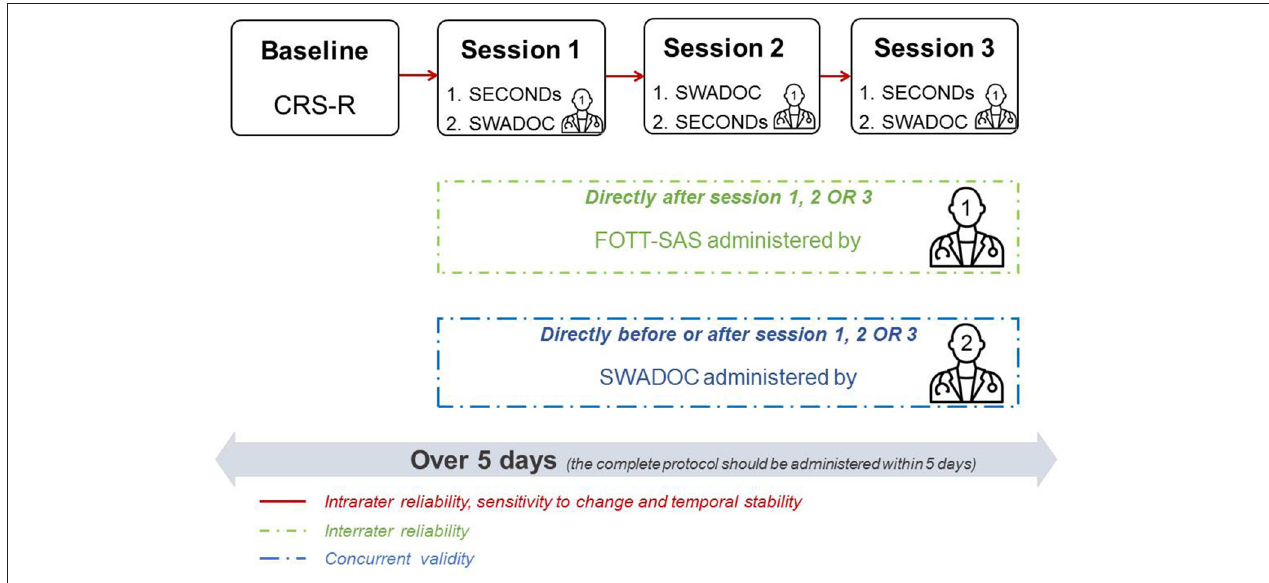
FIGURE 3 | Study protocol. Example of the assessment program for a patient. The program for each patient is organized such that the three sessions take place over 5 days in the morning or in the afternoon. The SECONDs is administered before or after the SWADOC. Examiner 2 will administer the SWADOC before or after examiner 1 in one of the three sessions. Examiner 1 will score the FOTT-SAS after one of the three sessions. SECONDs, Simplified Evaluation of CONsciousness Disorders; SWADOC, SWallowing Assessment in Disorders Of Consciousness; FOTT-SAS, Facial Oral Tract Therapy Swallowing Assessment of